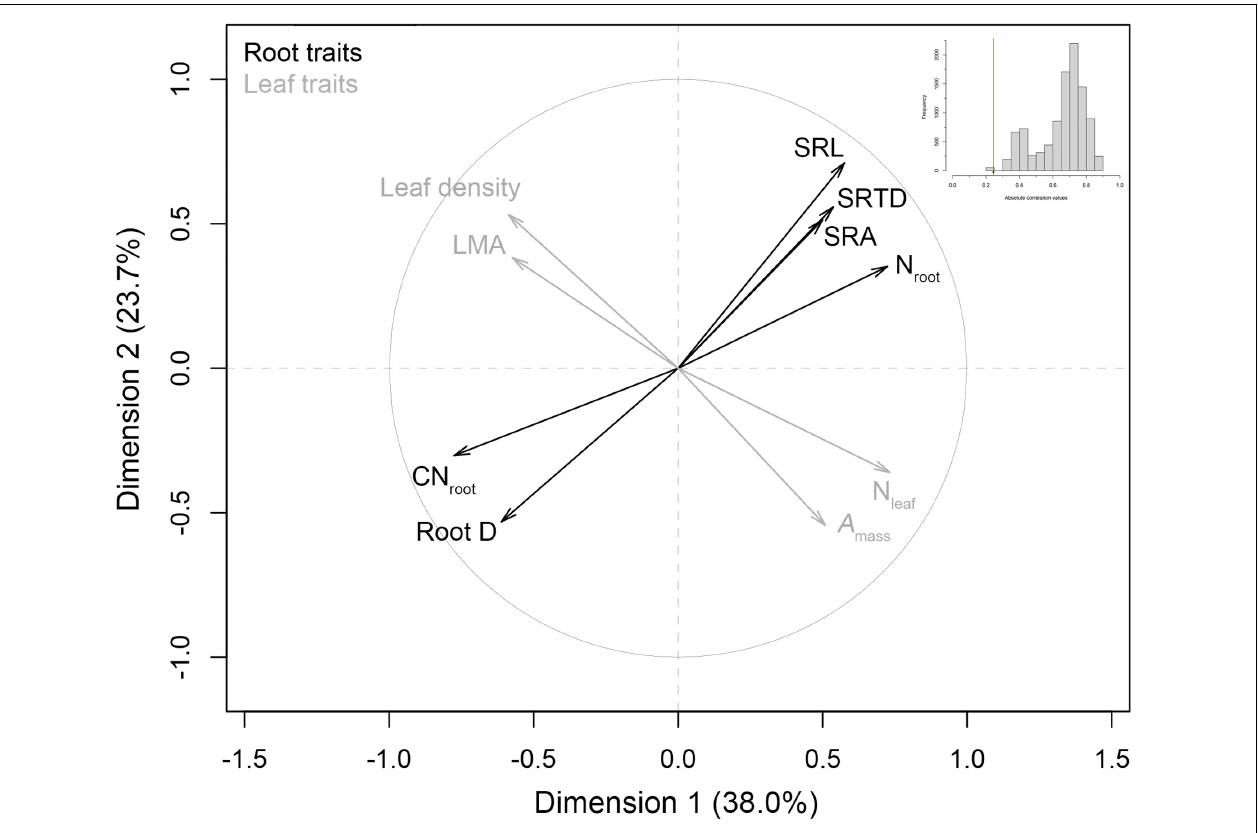
FIGURE 2 | Multiple factor analysis of root traits and leaf economics traits in C . arabica . Leaf traits were based on tree-level values derived from Martin et al. (2017), and a priori multiple factor analysis (MFA) groupings of root traits [with the removal of root length density (RLD)] and leaf traits, are denoted by gray and black coloring, respectively. A histogram of the randomized absolute correlation values (RV values) between these trait groups (where n = 10, 000 randomizations) is also presented as an inset. The red line indicates the observed correlation (RV) between root and leaf groups, relative to the distribution expected if traits were randomly assigned to